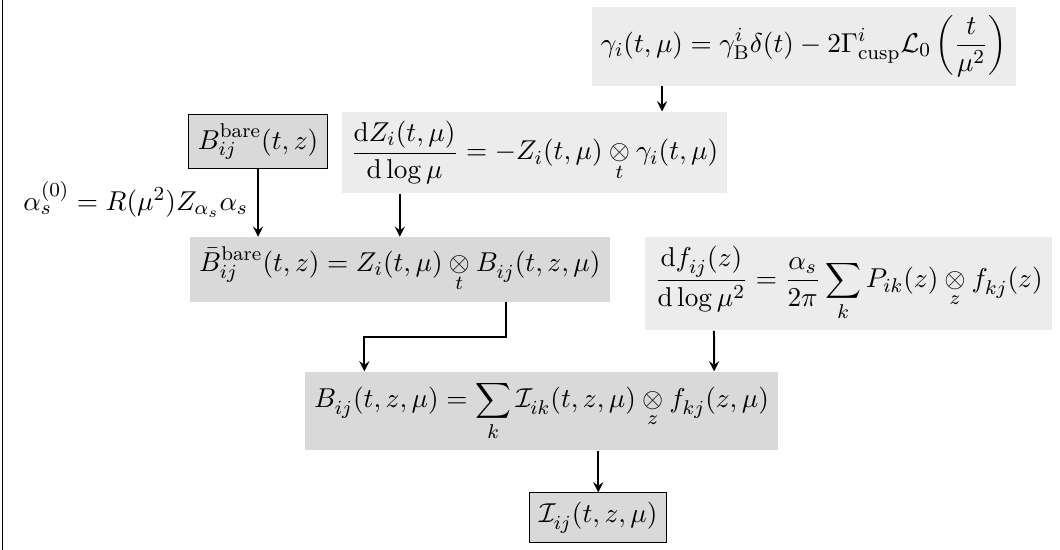
( t, z, µ ) from the fully ij ( t, z, µ ) , whose calculation is described in the ij